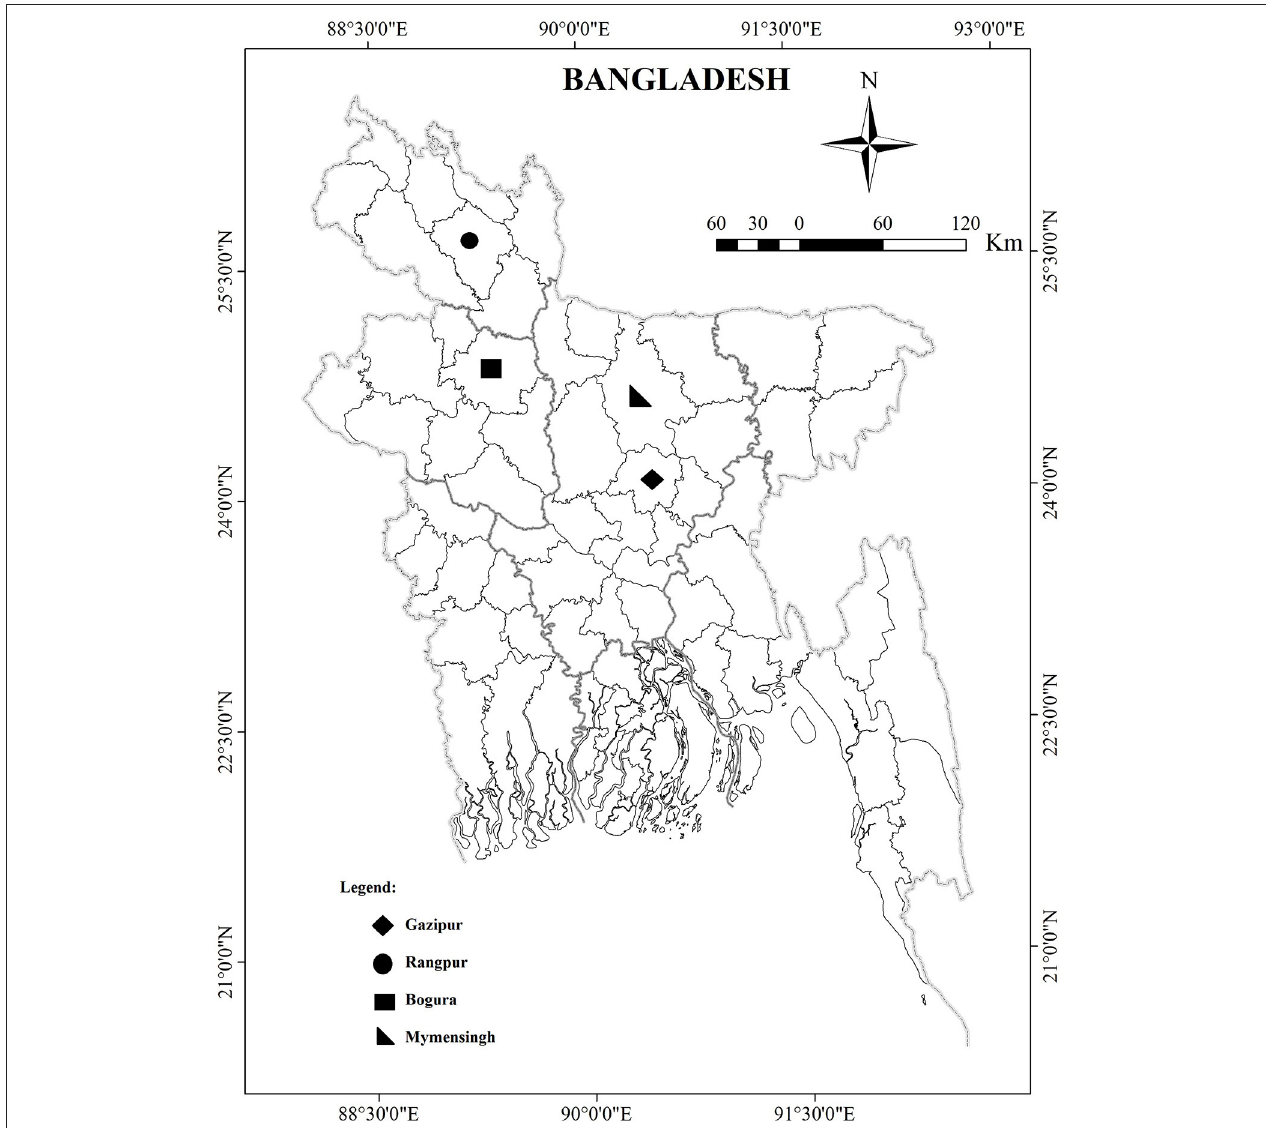
FIGURE 1 | Map of Bangladesh depicting sampling location.